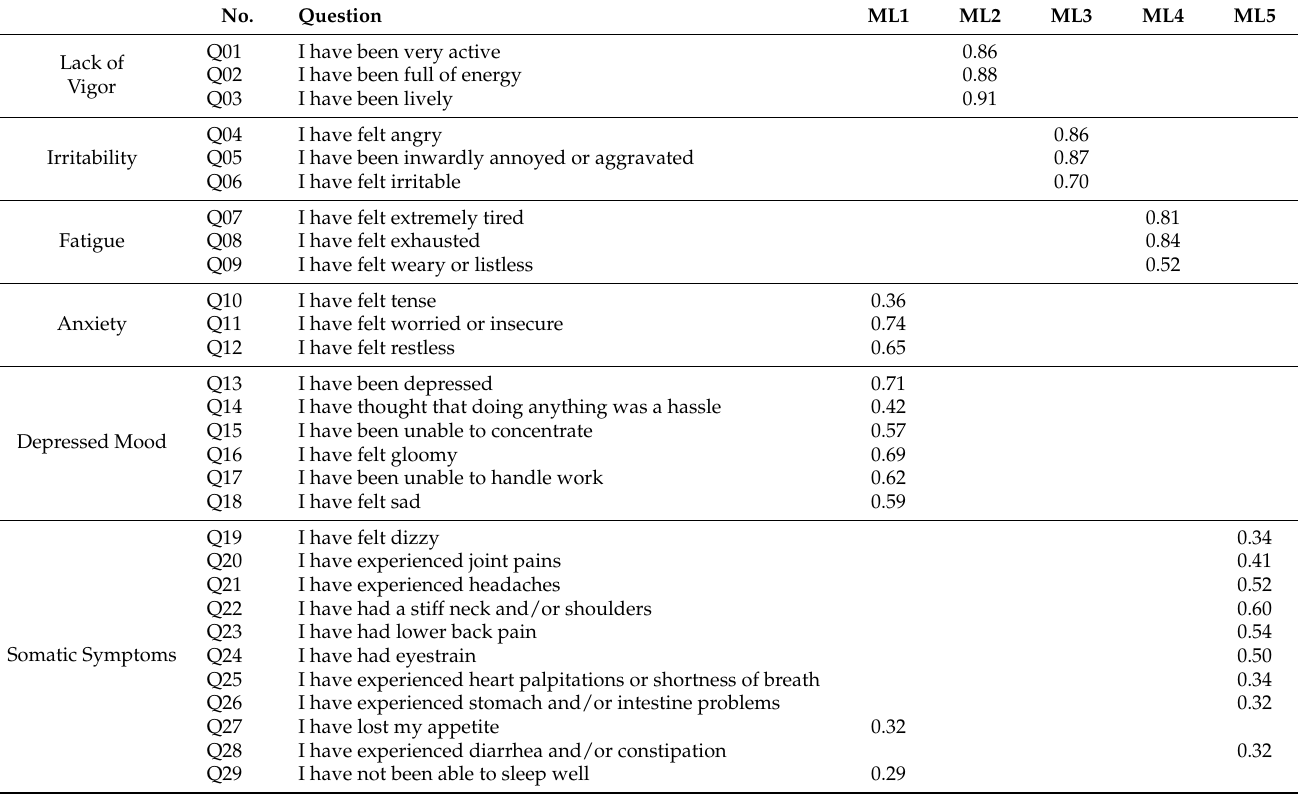
Table 2. Factor analysis of the 29 items of the BJSQ psychological and physical stress reactions.